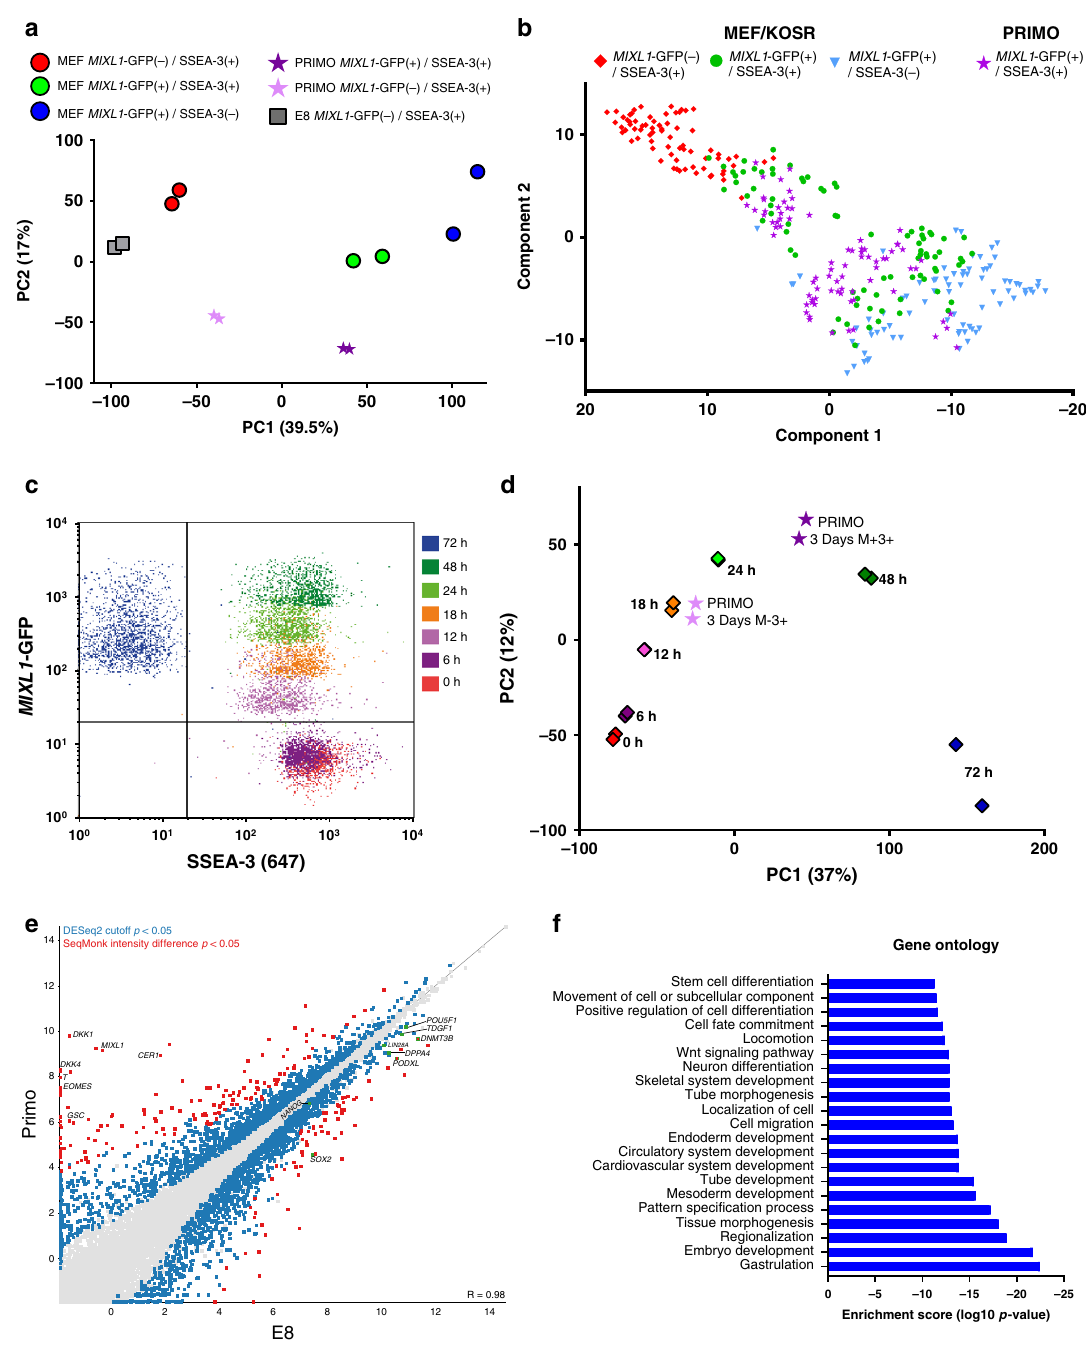
Fig. 4 Cells in PRIMO transcriptionally correlate with the MEF/KOSR substate and early mesodermal differentiation. a Principal component analysis of MIXL1 -GFP( + )/SSEA-3( + ) (dark purple stars) and MIXL1 -GFP( − )/SSEA-3( + ) (light purple stars) cells grown in PRIMO compared to the fractions identi fi ed in MEF/KOSR conditions (circles) and standard E8 culture (grey squares). b t-Distributed Stochastic Neighbour Embedding (t-SNE) plots of the expression of 45 genes in individual cells measured by Fluidigm Biomark qPCR and analysed by Monocle2. Displays all fractions in the same dimensional space from MEF/KOSR conditions (presented in Fig. 1c) MIXL1 -GFP( − )/SSEA-3( + ) cells as red squares, MIXL1 -GFP( + )/SSEA-3( + ) cells as green circles, MIXL1 -GFP( − )/SSEA-3( + ) cells as blue triangles and PRIMO conditions MIXL1 -GFP( + )/SSEA-3( + ) cells as purple stars. c Flow cytometry dot plot of the emerging population for which was sorted at the indicated timepoints during a differentiation time-course. Differentiation was induced incubating cells with E8 containing CHIRON at 3 µ M for 72 h. d Principal component analysis of MIXL1 -GFP( + )/SSEA-3( + ) (dark purple stars) and MIXL1 -GFP( − )/SSEA-3( + ) (light purple stars) cells grown in PRIMO compared to the differentiation time course (coloured squares). e Gene expression scatter plot of bulk RNAseq analysis of cells grown in E8 compared to PRIMO medium. Differentially expressed genes were identi fi ed by DESeq2 with a cut off p value of <0.05 (blue squares) and the SeqMonk intensity difference fi lter with a p value cut off <0.05 (red squares). Some key genes related to pluripotency are shown as green squares. f Gene ontology (GO) statistical enrichment analysis was performed by ToppGene 64 and Revigo 62 on the list of genes from the SeqMonk 59 intensity difference fi lter. GO terms which were signi fi cantly enriched are shown, the Log10 p values for each GO term are displayed. GO terms related to early differentiation and gastrulation are signi fi cantly enriched. b , e Source data are provided as a Source Data fi